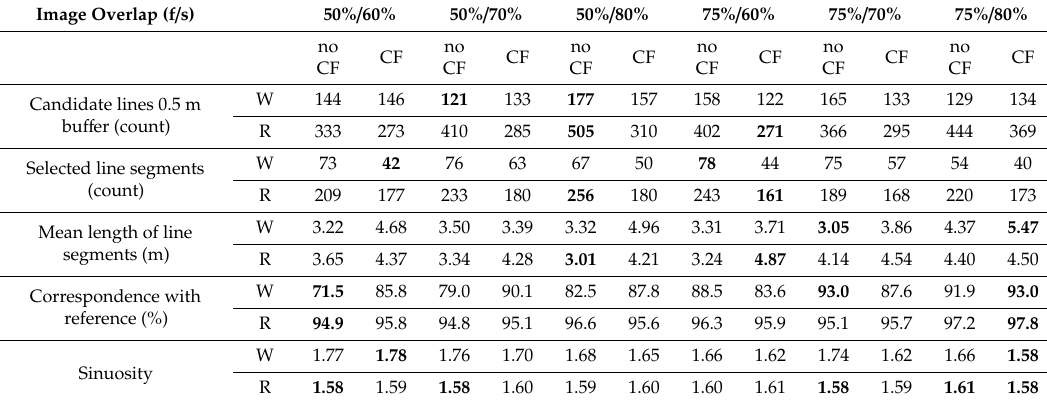
Table 6. Qualitative and quantitative characteristics of line geometries representing rooftops (R) and walls (W) separated according to flight configuration (forward overlap (f), side lap (s)) and flight pattern (CF = cross flight pattern, no CF = no cross-flight pattern). Minimum and maximum values are presented in